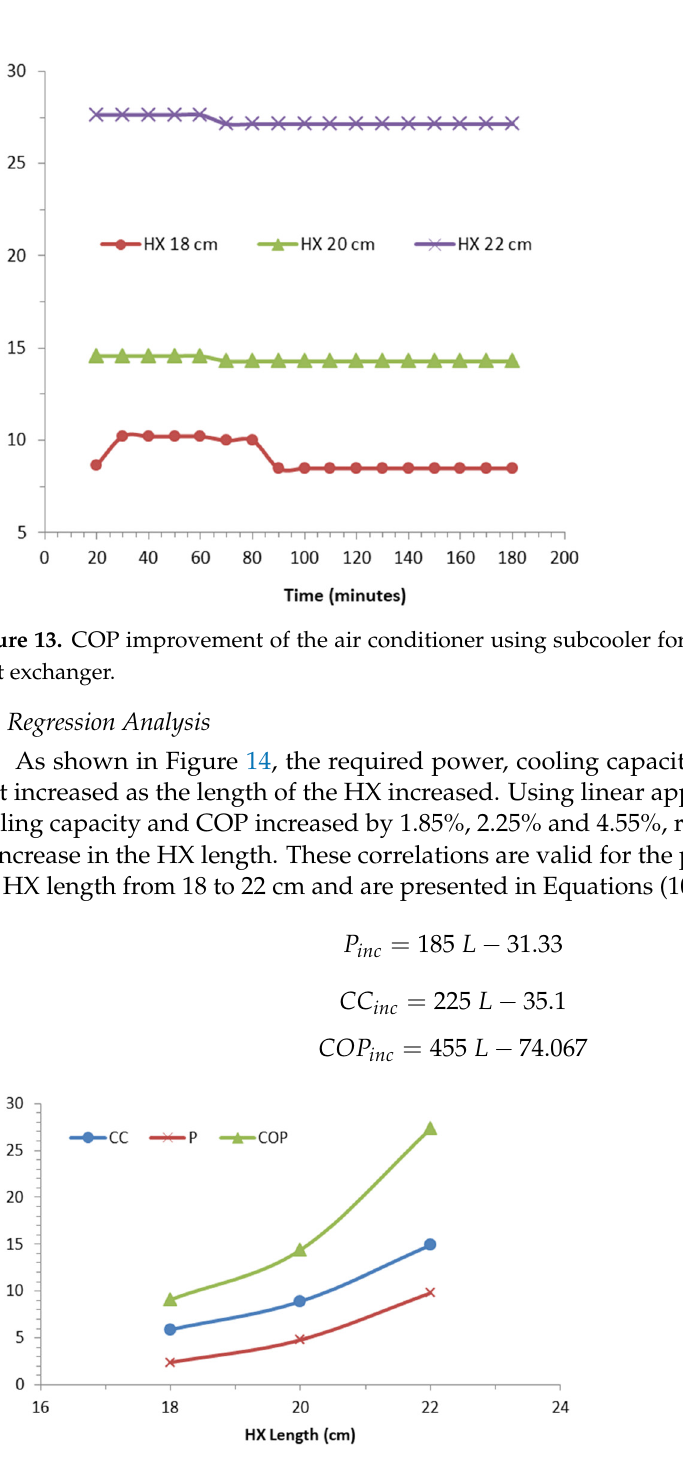
Figure 14. Cooling capacity, input power and COP improvements of the air conditioner using subcooler for three different lengths of heat exchanger.